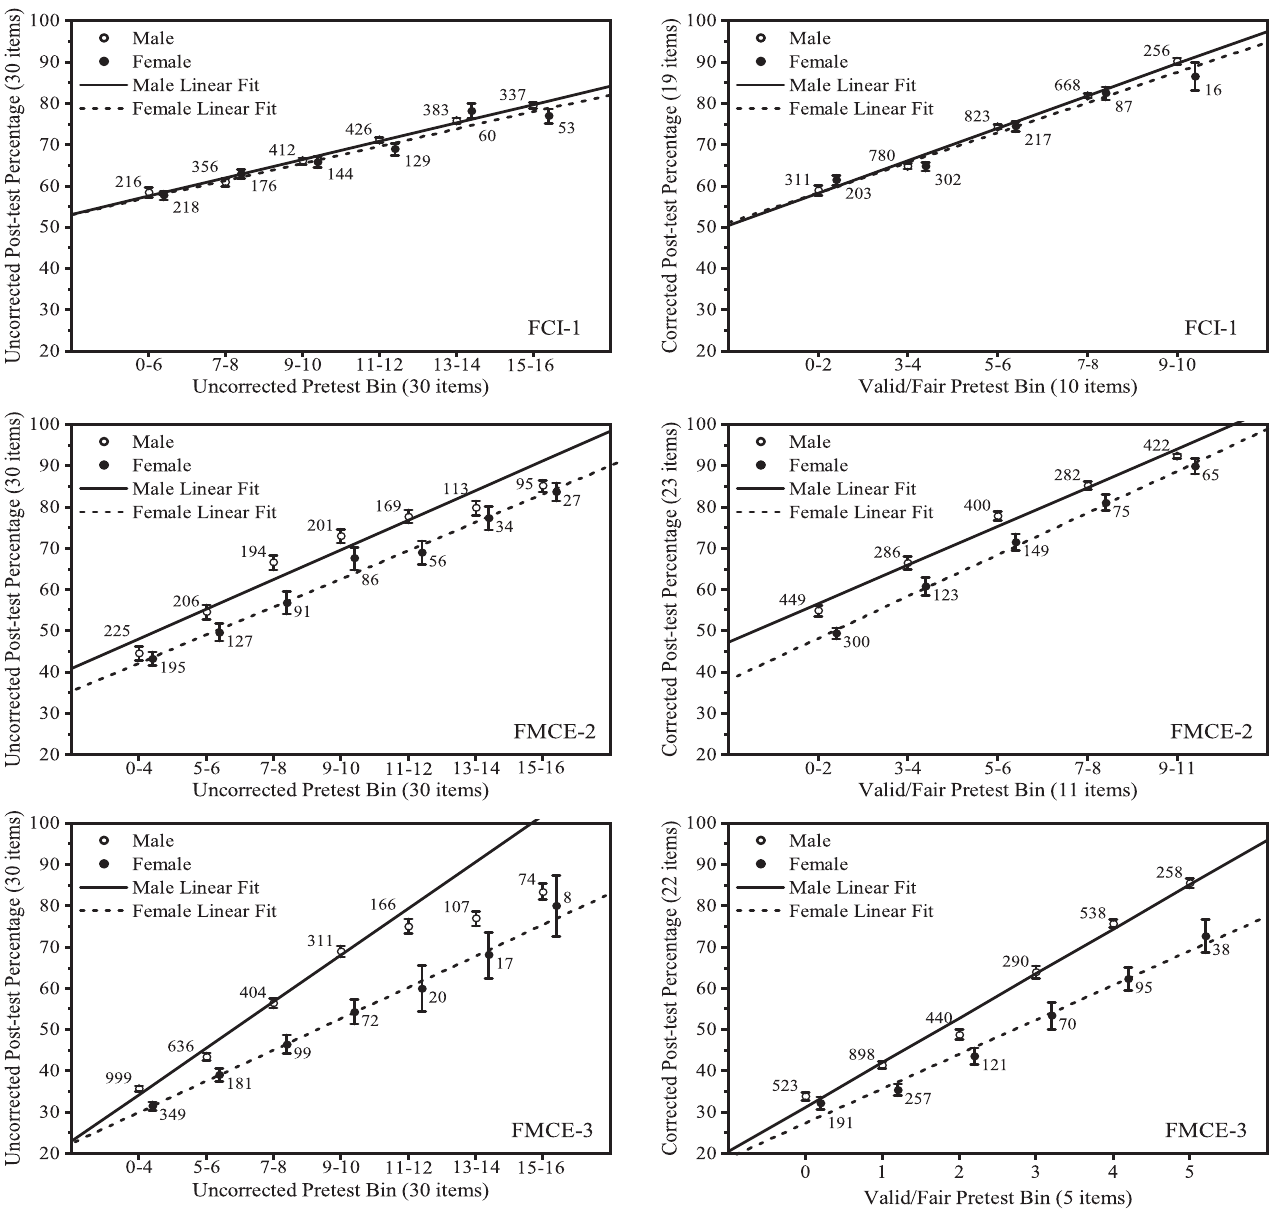
FIG. 1. Post-test vs pretest. Average pretest and post-test percentage scores on the uncorrected (left column) and corrected (right column) mechanics instruments. Linear fits only included bins containing greater than 30